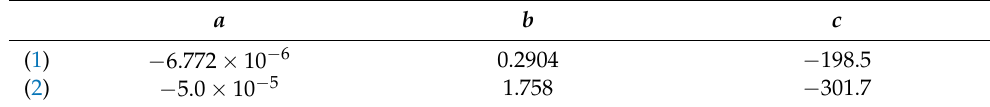
Table 4. Polynomial CHP model